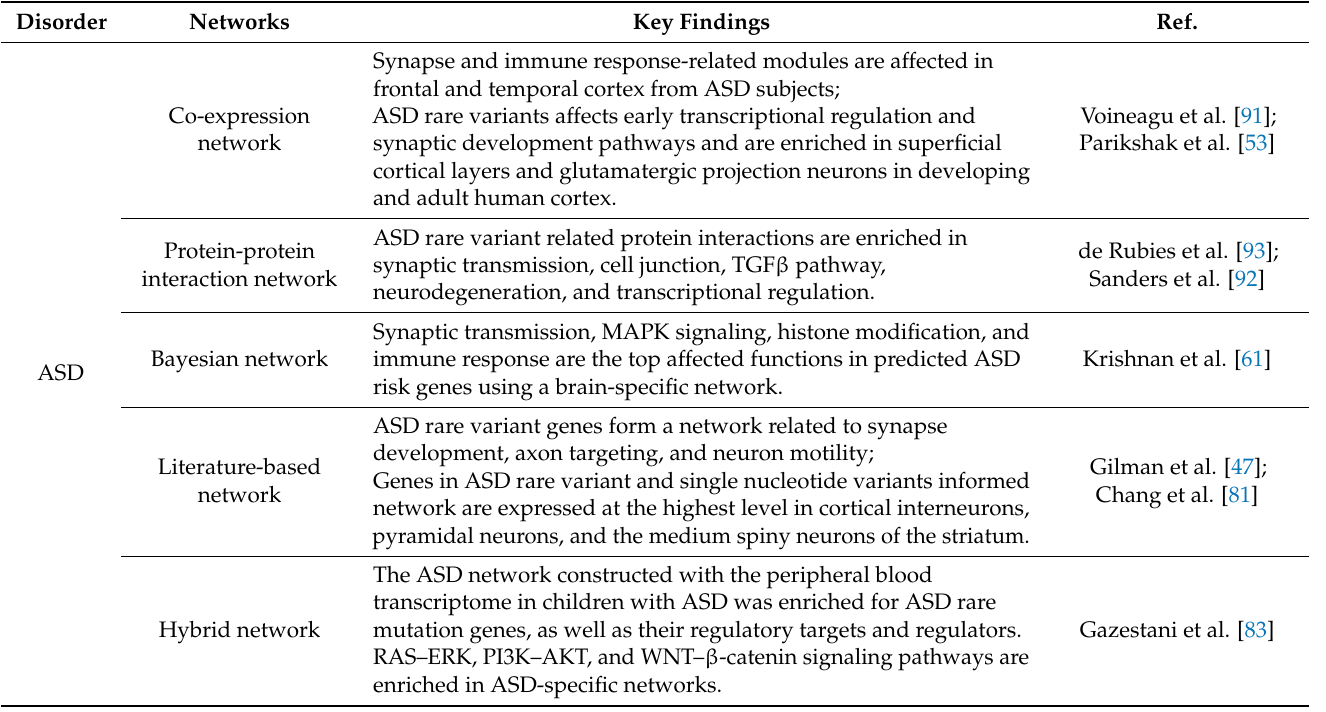
Table 3. Key findings based on network applications in selected psychiatric disorders. Key